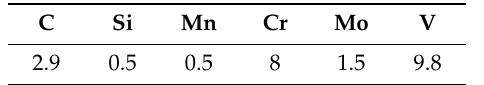
Table 1. Chemical composition